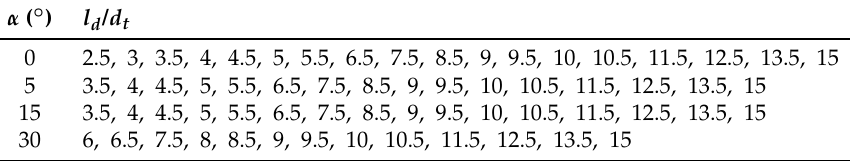
Table 2. Testing cases list.